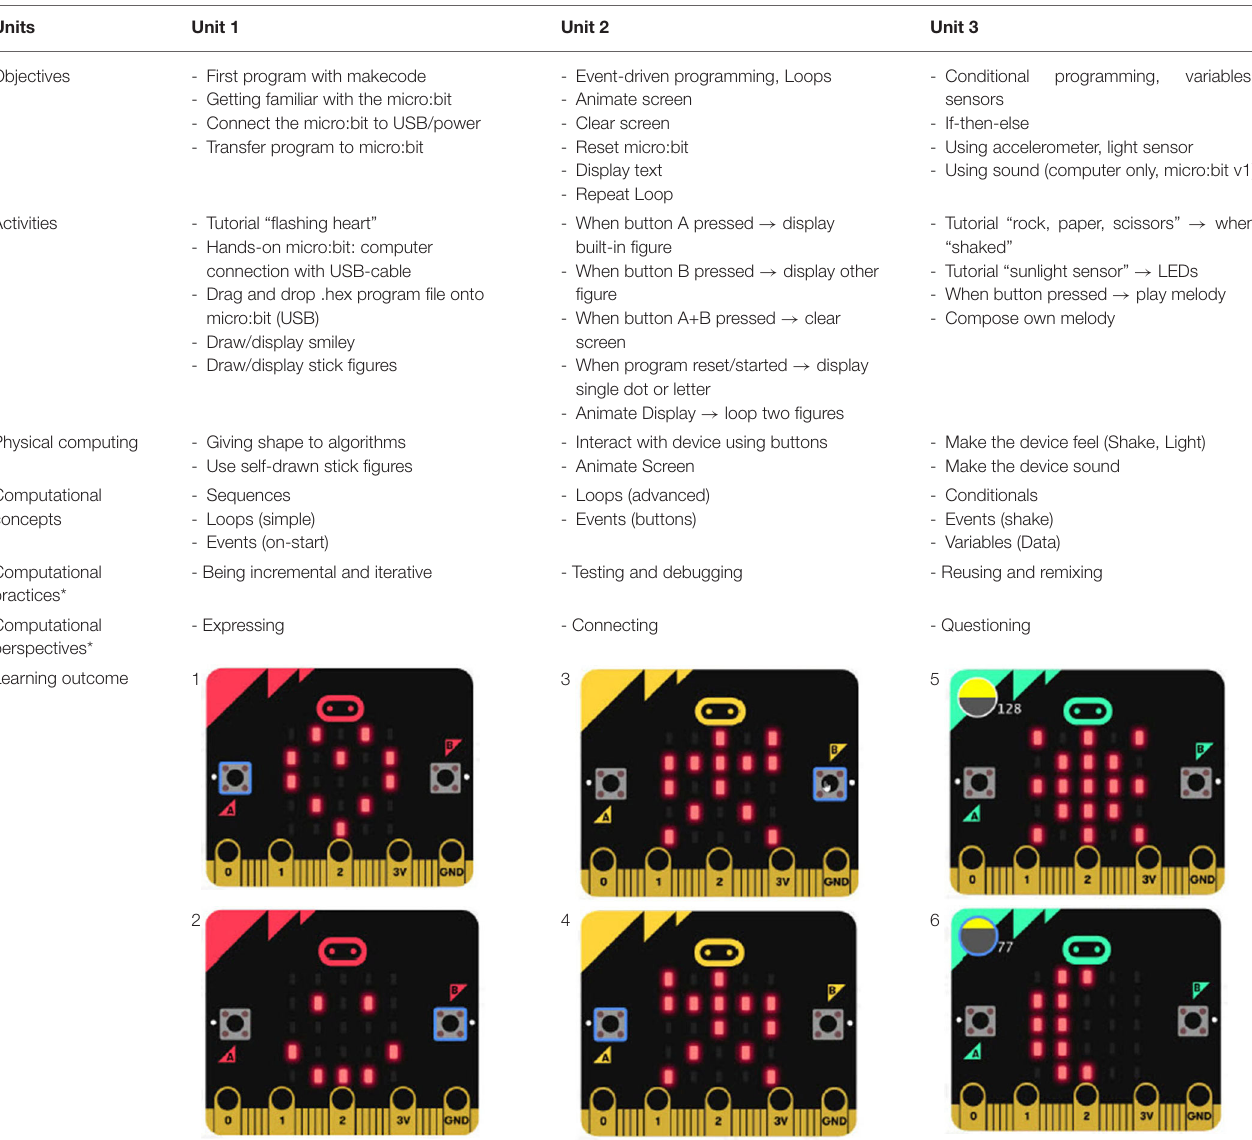
TABLE 2 | Lesson plan design—integrated learning environment.